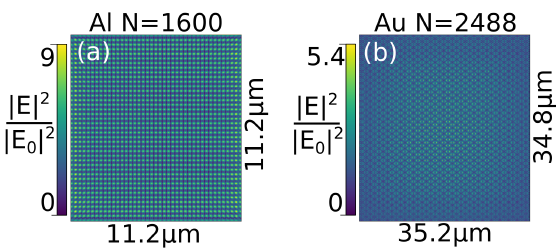
Figure 7. Electric field distribution at x–y plane with z = 65 nm for ( a ) Al square array of N = 1600 NPs and ( b ) Au honeycomb array with N = 2488